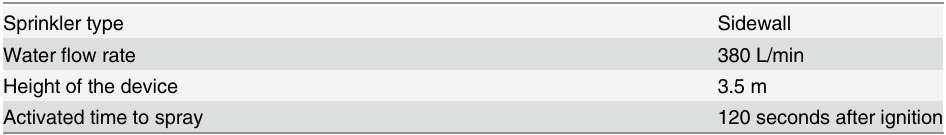
Table 2. The spray nozzle